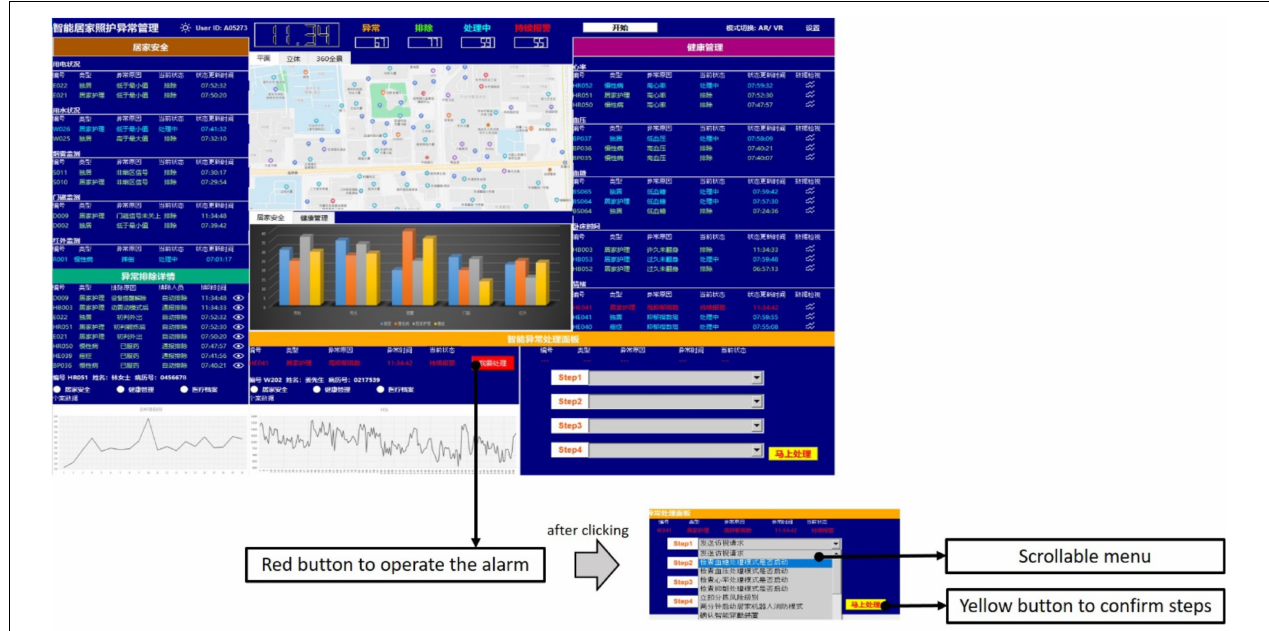
FIGURE 3 | The alarm requiring participants to process in operations.